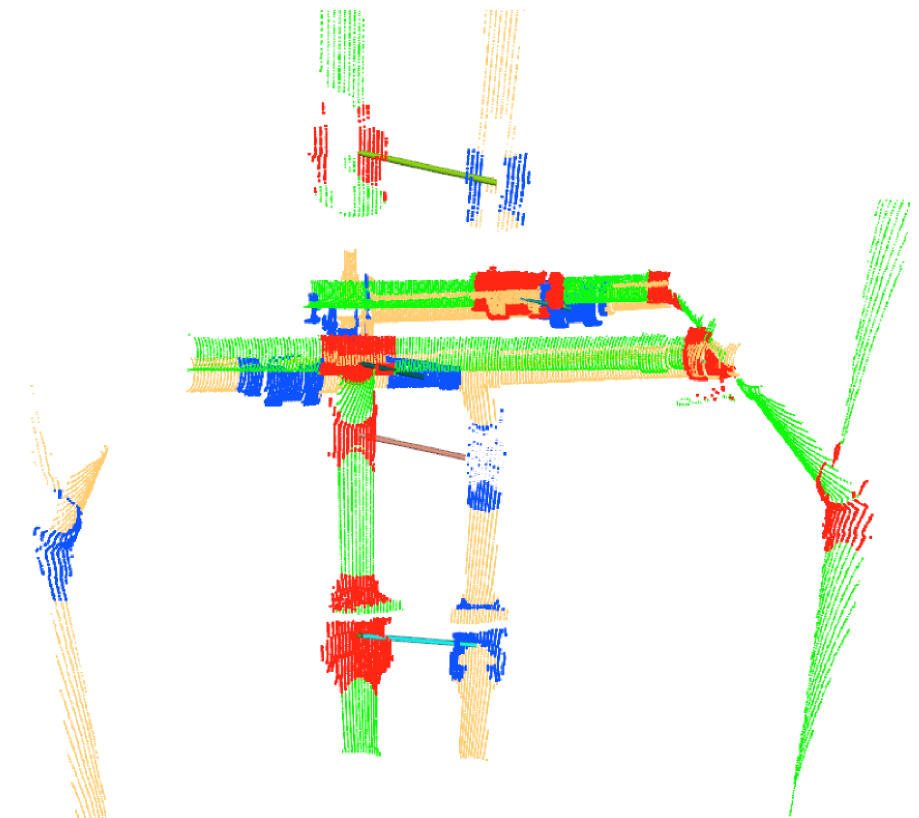
Figure 9. Tracking objects over two consecutive scans, represented in green/red and yellow/blue. The significant displacement between the two scans is the results of navigation inaccuracies from noisy Doppler Velocity Log (DVL) readings in the test pool. The solid lines indicate the objects associated by the